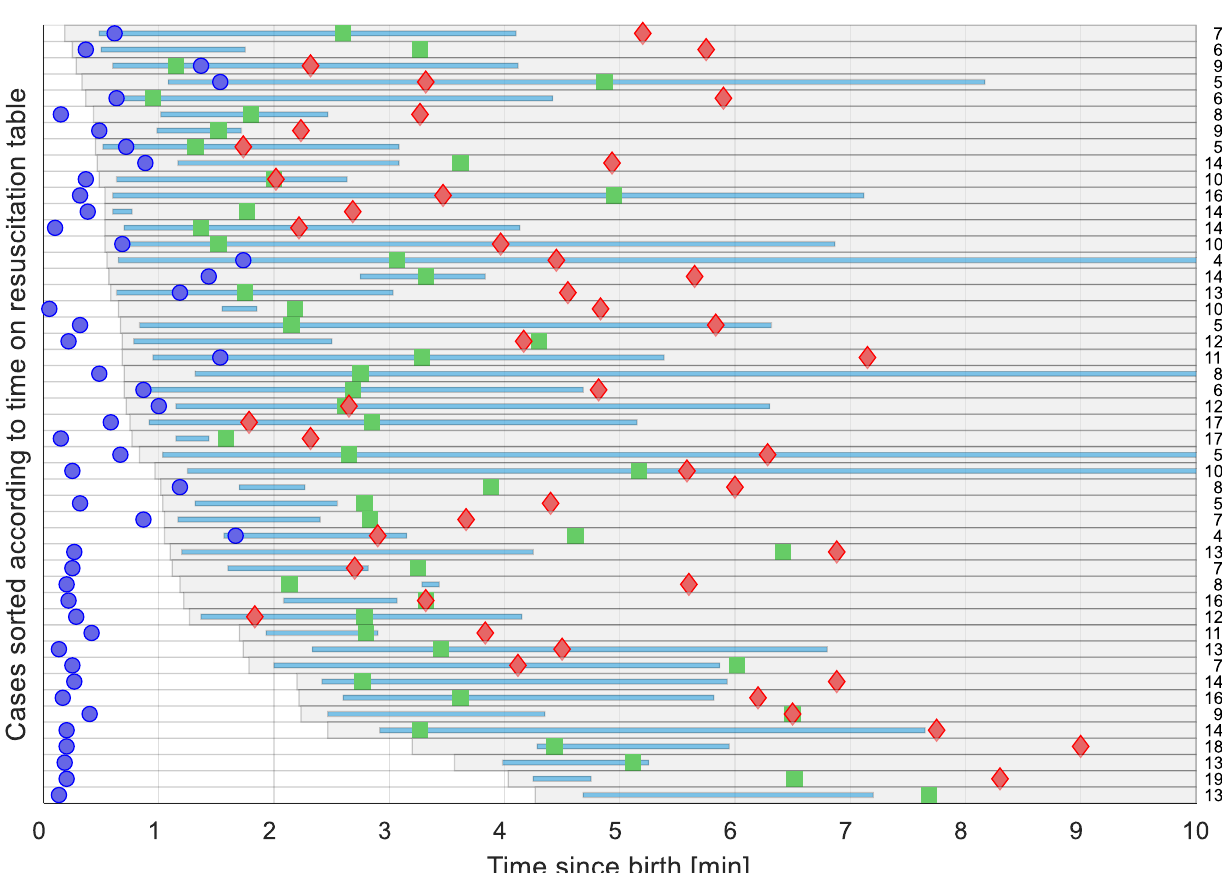
Figure 5. Timelines illustrating the 48 resuscitated newborns sorted according to time of placement on the resuscitation table from the time of birth. Each grey row represents time on the resuscitation table. Blue lines represent duration of PPV. First acquired heart rate is presented as blue dots for NeoBeat, green squares for gel-electrode ECG, and red diamonds for Pulse Oximetry. Number on the right-hand edge is the first heart rate in bpm for each case.